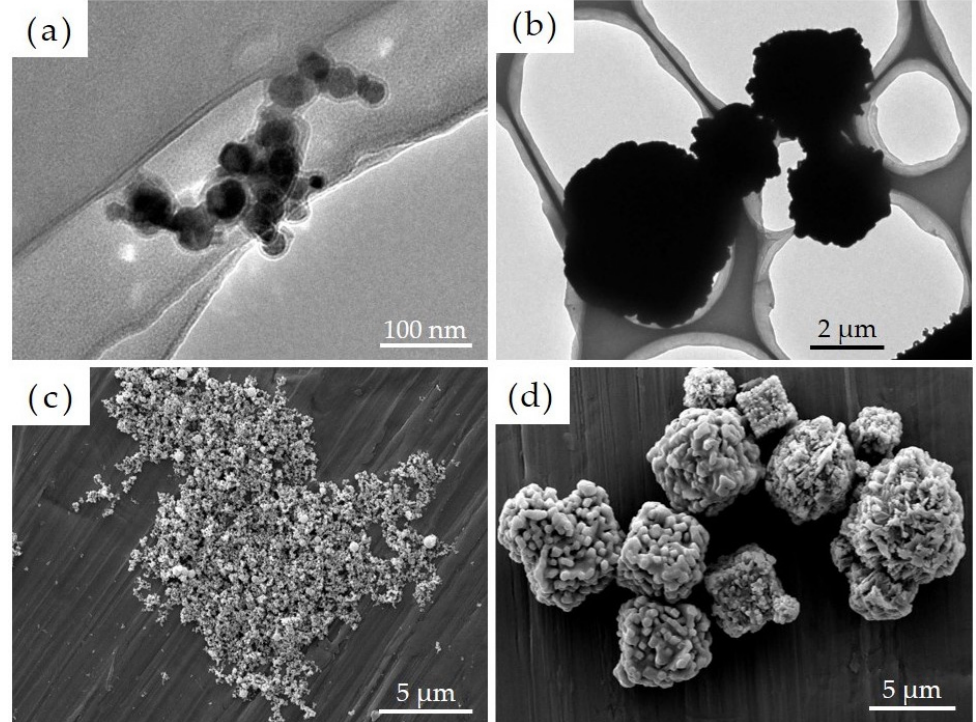
Figure 1. Transmission electron microscope images of each particle showing ( a ) nickel nanoparticles (Ni-NPs) and ( b ) nickel microparticles (Ni-MPs). Scanning electron microscope images of ( c ) Ni-NPs and ( d ) Ni-MPs are also shown.